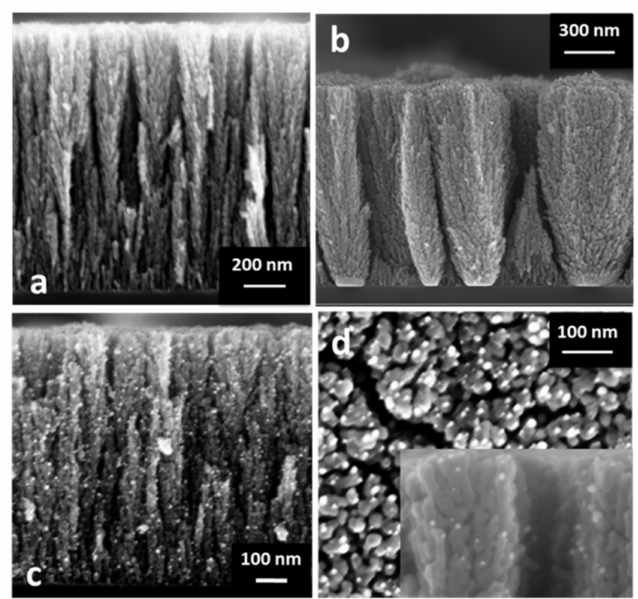
Figure 1. SEM images of ( a ) reference TiO 2 film (cross section); ( b ) TiO 2 /Au film (cross section); ( c ) TiO 2 –Au film (cross section); ( d ) the Au/TiO 2 film (top surface; in the inset the film cross section close to the surface shows the penetration of Au